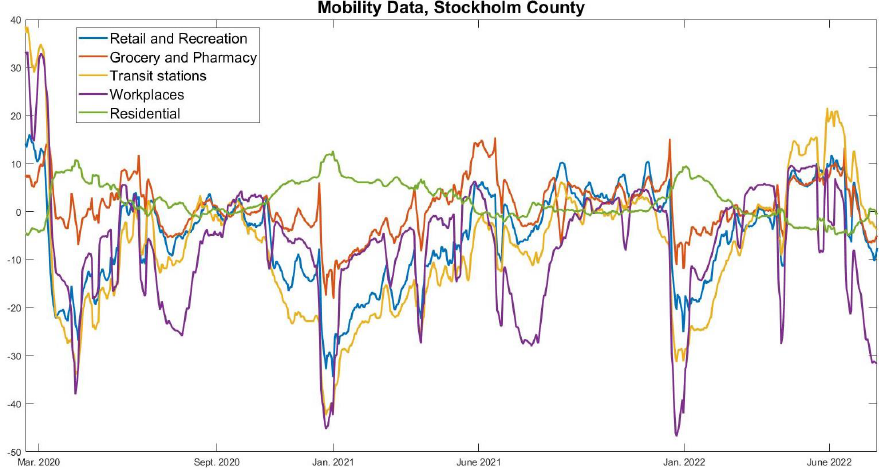
Figure 5. Google-mobility data over the full pandemic time-frame, preprocessed as in Figure